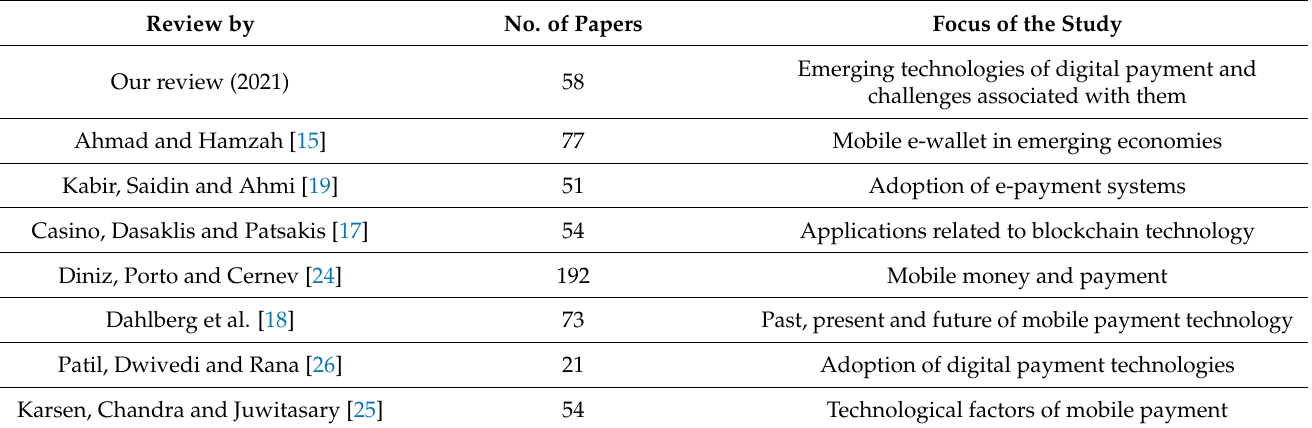
Table 1. Previous reviews vs. this